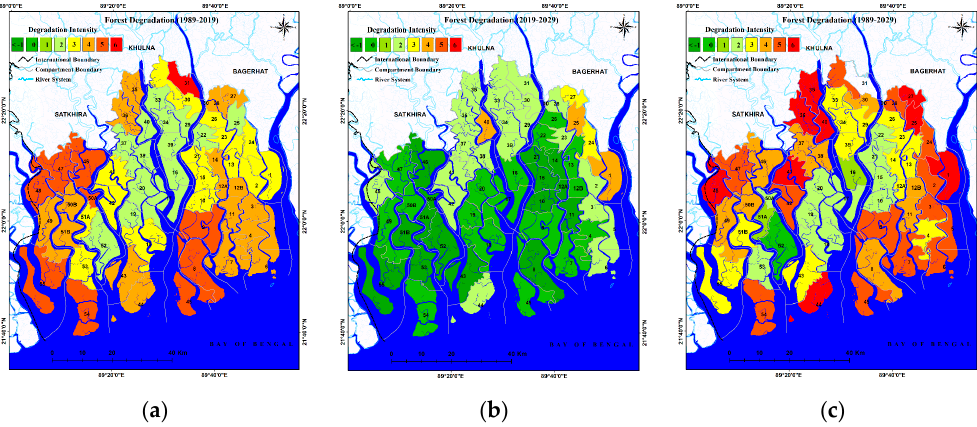
Figure 10. Spatial forest degradation (SFD) assessment for three different time periods by forest degradation intensity (FDI) mapping. ( a ) Forest degradation status in 1989–2019, ( b ) forest degradation status in the future (2019–2029), ( c ) overall forest degradation from past to future in 1989–